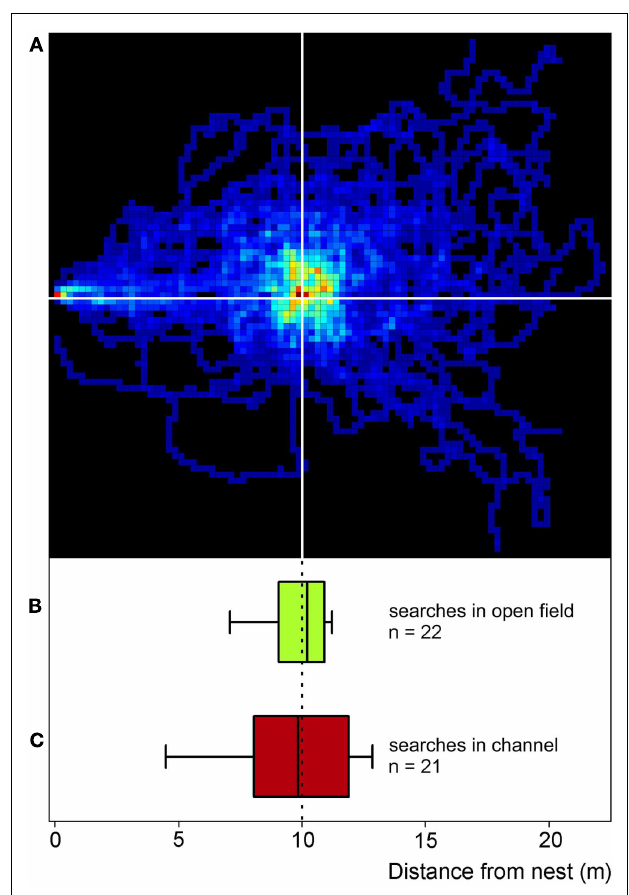
FIGURE 2 | Desert ants’ search behavior in the open field (compare Figure 1A) and in channels (compare Figures 1B,C). For the two-dimensional search density plot in (A) , the number of ants’ visits to each 25cm × 25cm pixel of the feeder surrounds was recorded, summed, and normalized to the maximum number of visits per pixel in the plot.The darkest red represents the highest density (100%), the darkest blue just a single visit, and black areas were not visited at all (0%). Recordings lasted for 2.5min after an animal had left the nest (note red pixel on the left hand margin); nest-feeder distance was 10m.The ants ( n = 31) had visited the full feeder ( > 800 biscuit crumbs) once before the recordings were made.To construct the box plot in (B) , the data in (A) were projected onto the nest-feeder axis, i.e., any movements along the axis perpendicular to the nest-feeder direction were disregarded. Like in the channel experiments [see (C) ], the initial six turning points on the nest – feeder axis were used to calculate medians and percentiles (below; n = 22, since not all 31 ants performed six turns in the projected path as required for the analysis).The box plot in (C) presents searches recorded in the test channel used in all the other experiments described in this report ( Figure 1C ).The ants had visited a full feeder once in the training channel (as in the open field) before the recordings were made. Note the similarity of the plots in (B,C) , attesting to comparable search behavior in the channel and in the open field. Box plots show medians, box margins ( + 75th, − 25th percentiles) and whiskers ( + 90th, − 10th percentiles) in this and all following